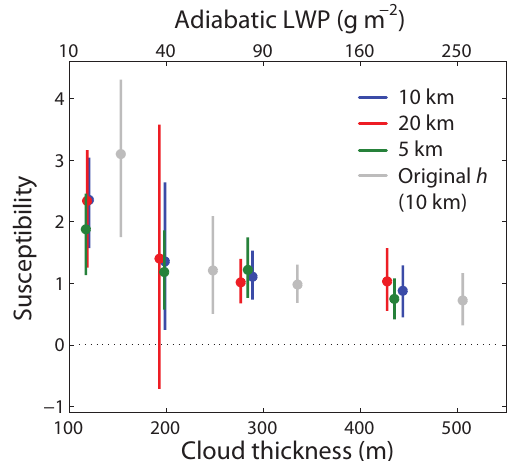
Fig. 9. After combining LWP retrievals from the GVR and the cloud thickness measurements from the WCL and WCR into an integrated cloud thickness dataset, the precipitation susceptibility are calcu- lated in four equally weighted cloud thickness bins for three differ- ent averaging length scales: 10km (blue), 20km (red), 5km (green). The original precipitation susceptibility using cloud thickness mea- surements derived from the WCL/WCR is shown in gray for com-